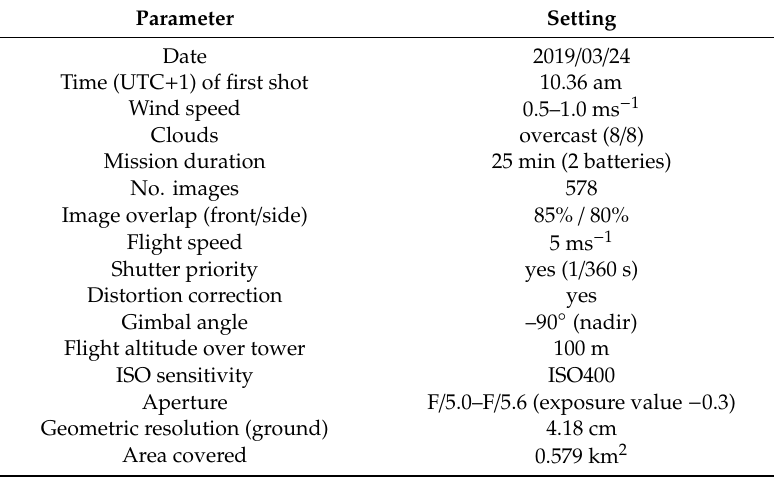
Table 2. UAS mission and acquisition parameters. Wind speed was measured at the weather station Weberstedt / Hainich located 5 km to the NE of the test site. The mission footprint (i.e., the entire area covered by the UAS campaign) is noticeably larger than the Huss site because the flight planning accounted for a bu ff er surrounding the site. Abbreviation: ISO = International Organization for